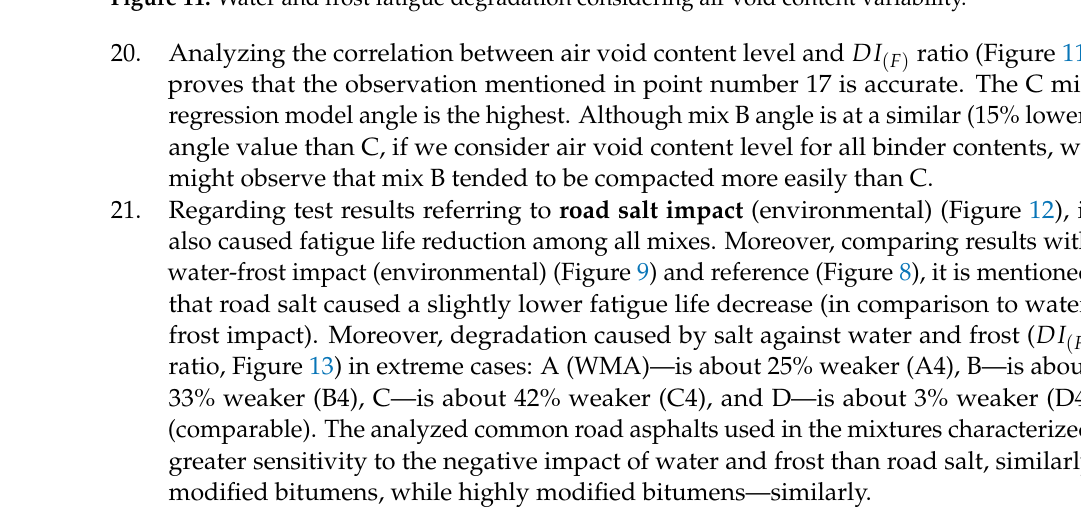
Figure 11. Water and frost fatigue degradation considering air void content variability. 21. Regarding test results referring to road salt impact (environmental) (Figure 12), it